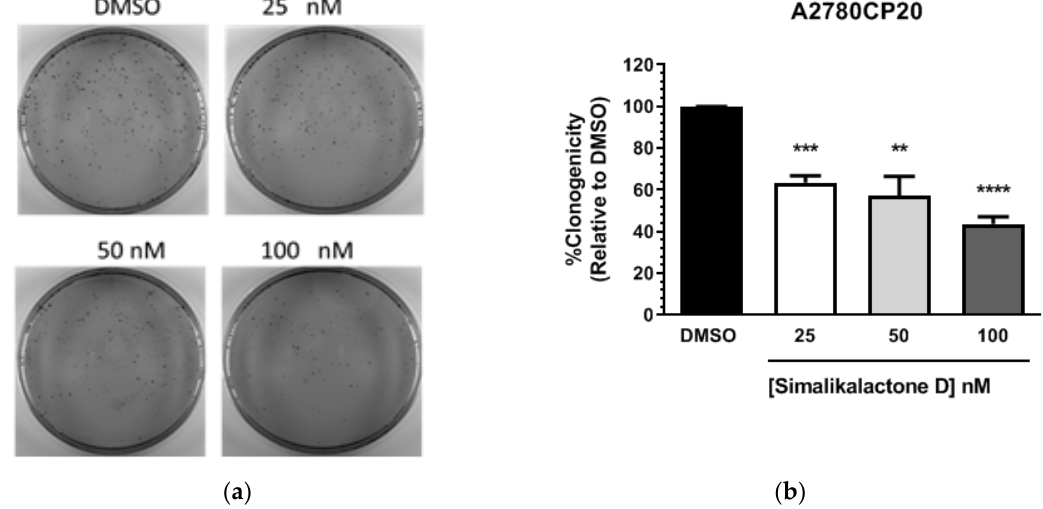
Figure 5. Anti-proliferative effect of SKD in cisplatin-resistant ovarian cancer cells, A2780CP20. Cells